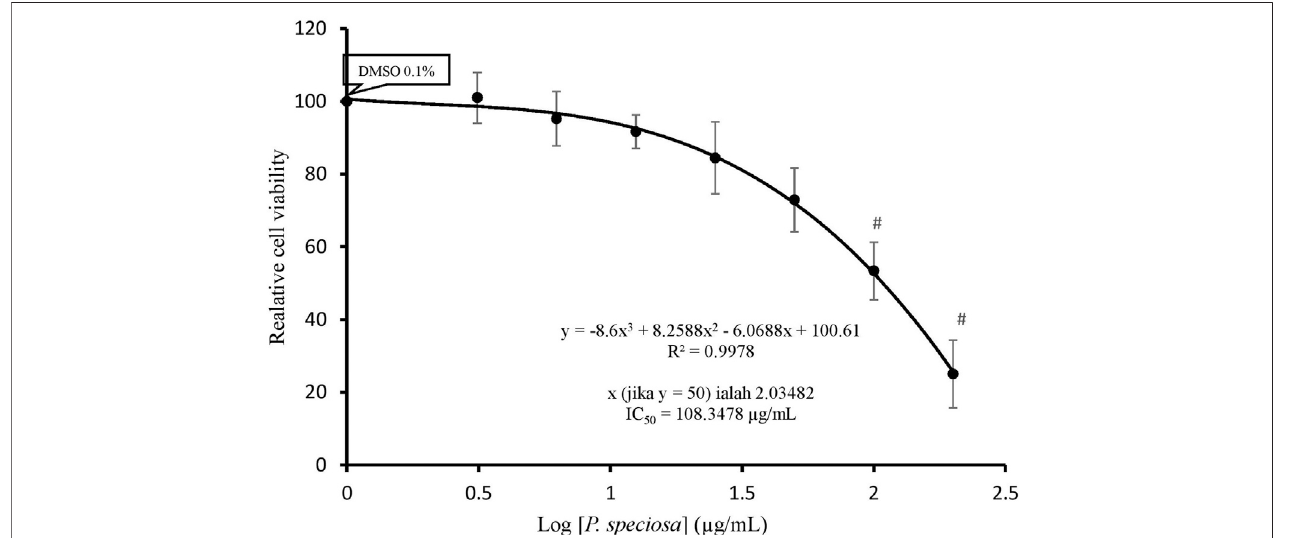
FIGURE 5 | Cell viability of H9c2 cells after 24 h exposure to Parkia speciosa empty pod extract at increasing concentrations. * p < 0.05 vs. control. Results are presented as the mean ± SEM ( n (cid:2) 3).